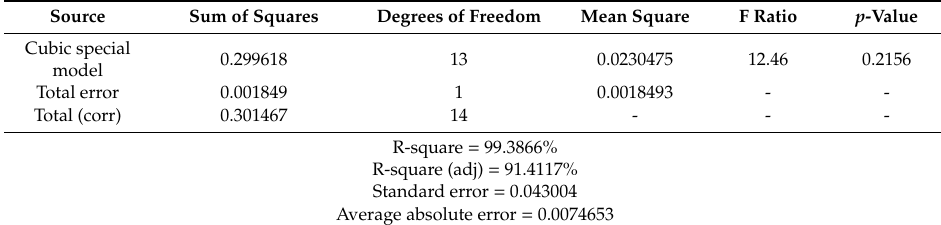
Table 3. ANOVA table of 100 mg · L − 1 for Si-Fe-Ni mixture design.